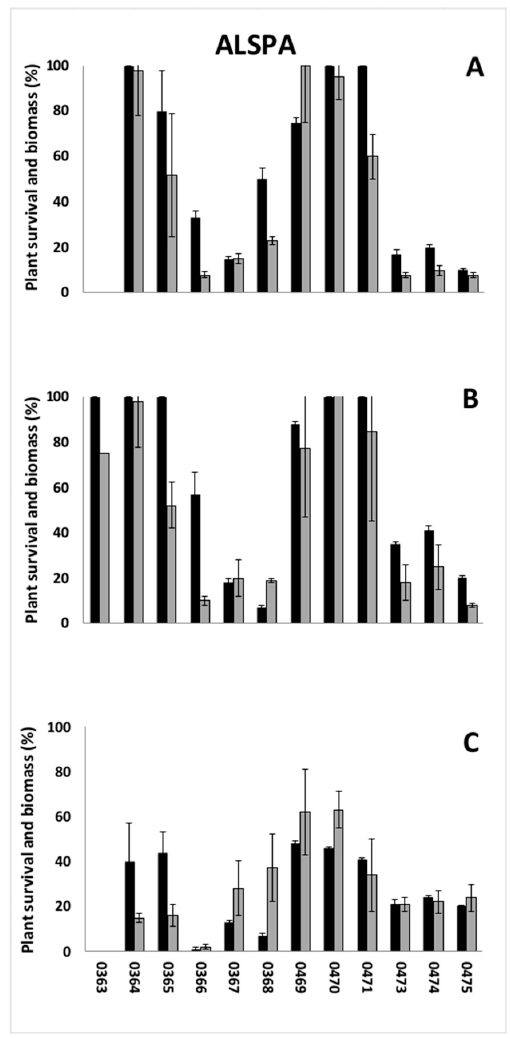
Figure 1. Sensitivity of populations of Alisma plantago-aquatica (ALSPA) to three ALS inhibitors, azimsulfuron ( A ), bensulfuron-methyl ( B ), applied at full label dose corresponding to 20 and 60 g ai ha − 1 respectively and penoxsulam ( C ), applied at half the full label dose, corresponding to 20 g ai ha − 1 . Population 0363 is an ALS-resistant check. Values of survival (black bars) and biomass (grey bars) are expressed as percentage of the untreated control. Vertical bars represent standard errors. Due to low germination obtained for population 0363, only the screening with bensulfuron-methyl was